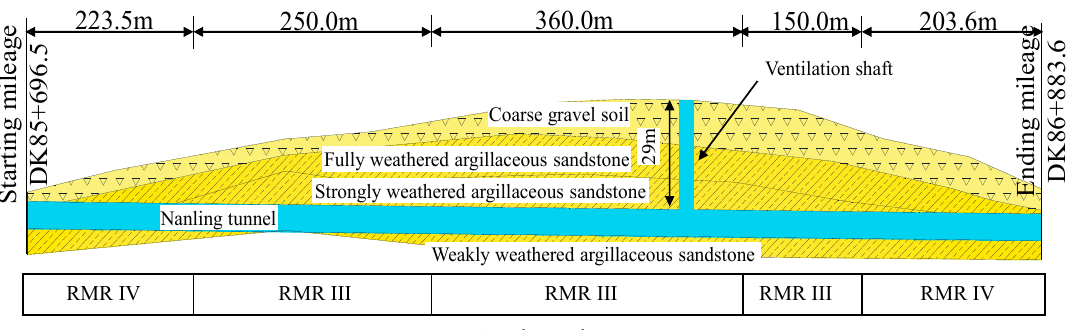
Figure 1. Geological conditions of Nanling tunnel.